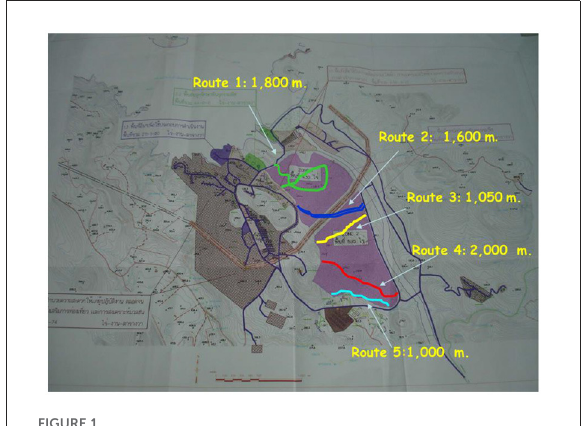
FIGURE1 Study sites, five routes, at Srinakarind Dam, Kanchanaburi province, Thailand.